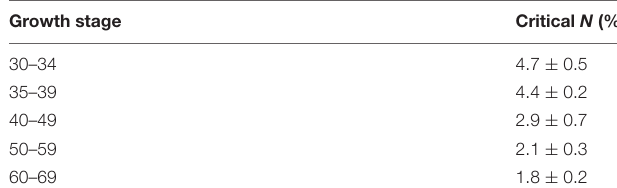
TABLE 1 | Average ( ± standard deviation) critical nitrogen concentration of wheat for Zadoks’ growth stages from early stem elongation to anthesis (Zadoks et al.,